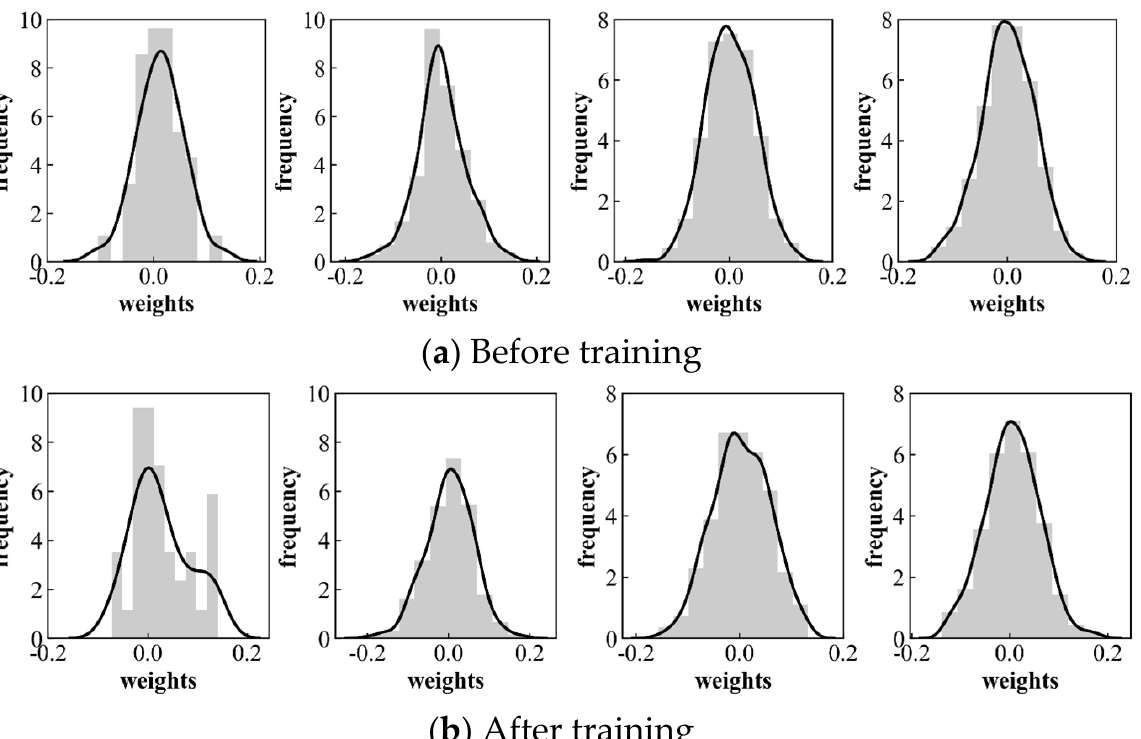
Figure 9. Loss curve and accuracy curve of federated fault diagnosis model.